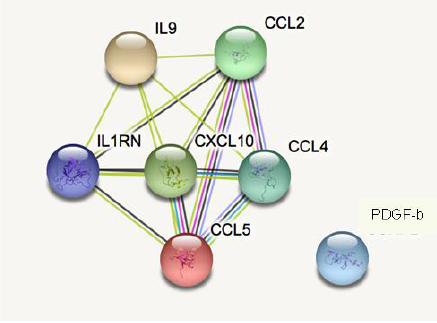
Figure 4. STRING bioinformatic analysis of proteins identified to be over-expressed in age-matched elderly individuals. The non-casual protein – protein interaction network was studied and predicted using STRING. The links between the proteins represent possible interactions (line thickness indicates the strength of association). The green lines indicate putative text mining associations suggested by further peer-reviewed publications; the black lines indicate putative co-expression; the pink lines indicate experimentally determined interactions; the blue lines indicate interactions suggested by curated databases; and the violet lines indicate protein homology.